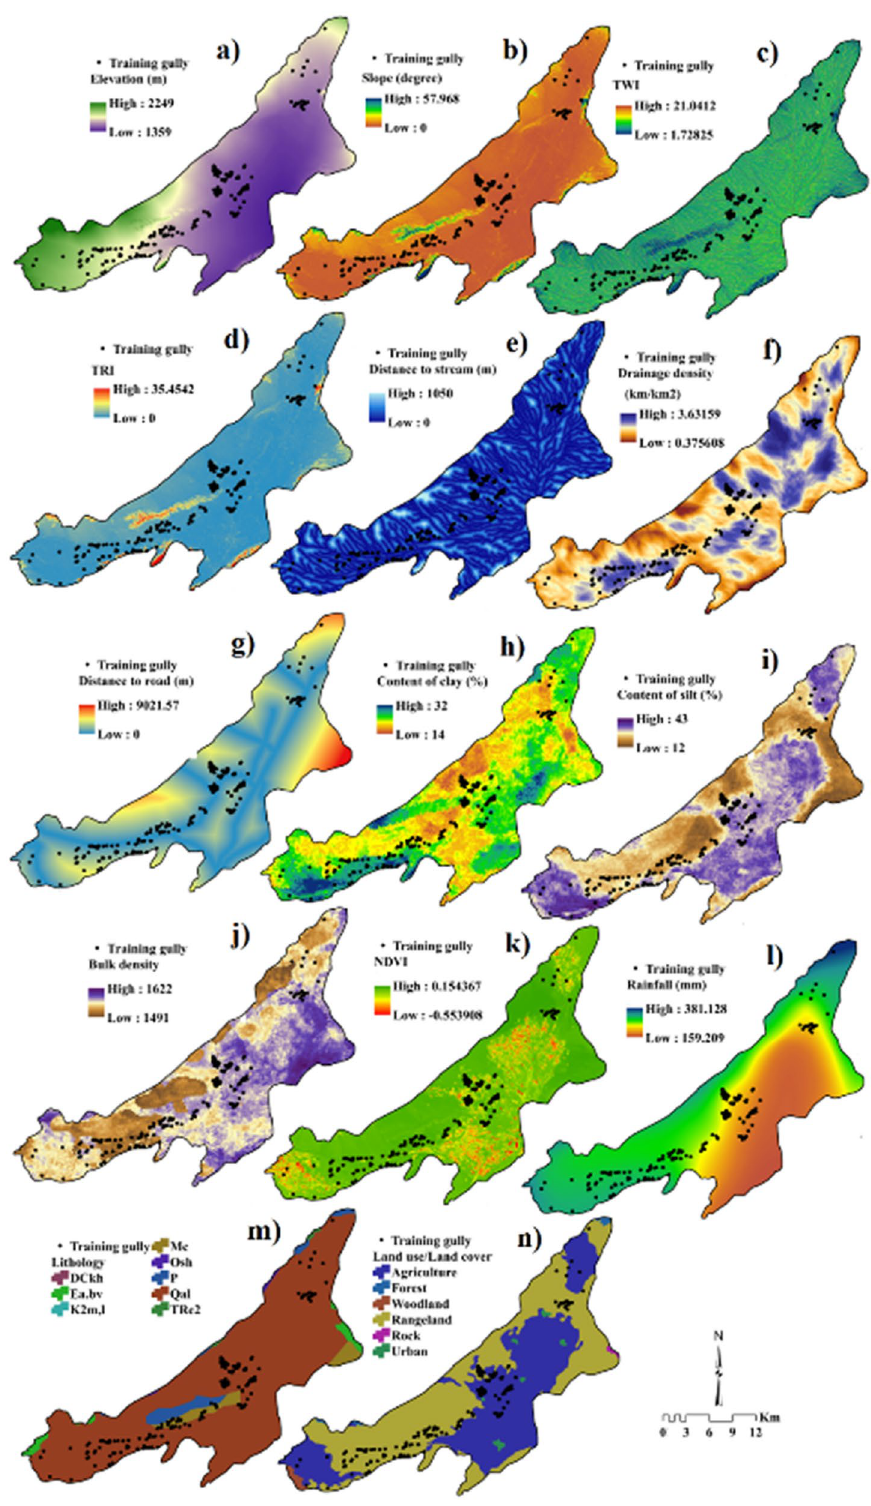
Figure 10. Gully erosion conditioning factors. ( a ) Elevation, ( b ) slope, ( c ) topography wetness index, ( d ) terrain rugged index (TRI), ( e ) distance to stream, ( f ) drainage density, ( g ) distance to road, ( h ) content of clay, ( i ) content of silt, ( j ) bulk density, ( k ) normalized difference vegetation index (NDVI), ( l ) rainfall, ( m ) lithology, ( n ) land use/land cover (LU/LC). The map was generated using ArcGIS 10.5 software (https ://deskt op.arcgi